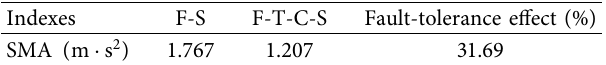
Table 8: The output RMS values of sprung mass acceleration in time domain.